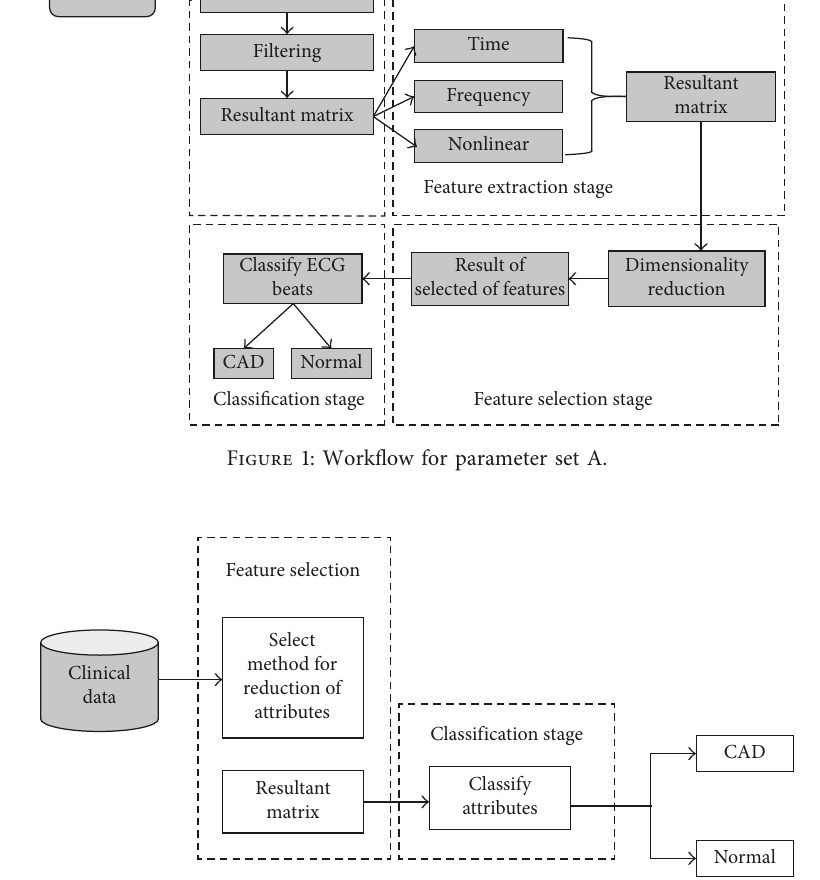
Figure 2: Workflow for parameter set